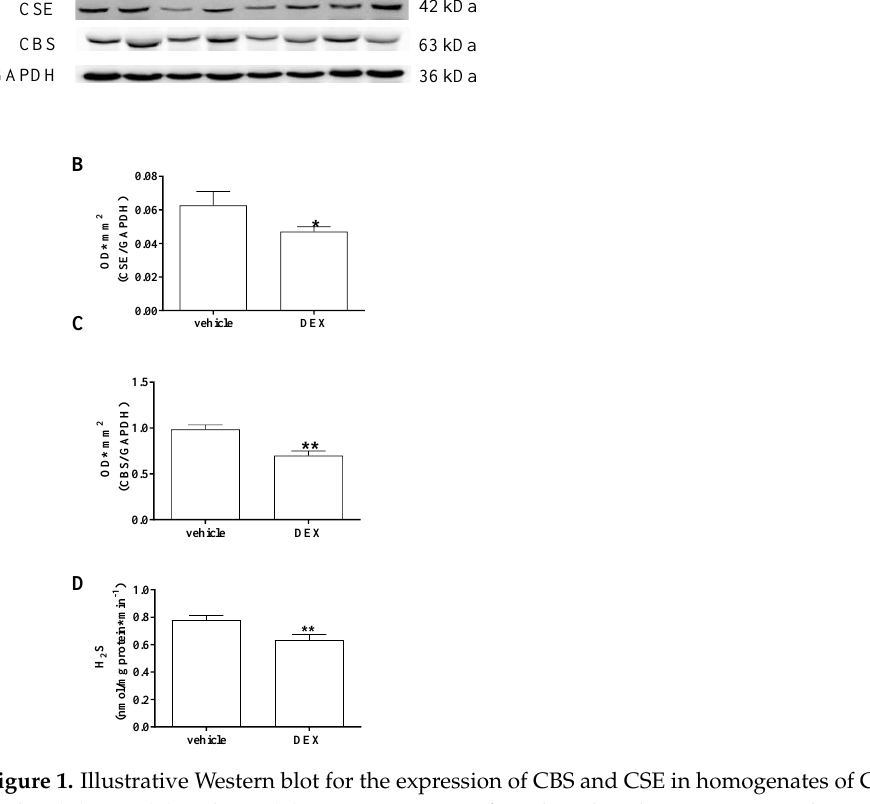
Figure 1. Illustrative Western blot for the expression of CBS and CSE in homogenates of C2C12 my- otubes ( A ). CSE ( B ) and CBS ( C ) expression is significantly reduced in C2C12 myotubes treated with DEX compared with vehicle (* p < 0.05, ** p < 0.001). Results are normalized against a housekeeping protein, GAPDH. Data are expressed as optical density (OD)*mm 2 and calculated as mean ± SEM of 5/6 experiments ( n = 5 vehicle; n = 6 DEX). H 2 S production in vehicle-treated or DEX-treated C2C12 myotubes ( D ). The basal amount of H 2 S is significantly reduced in homogenates of C2C12 myotubes treated with DEX compared with vehicle (** p < 0.01). Results are expressed as nanomoles per milligram of protein per minute and values are calculated as mean ± SEM of 9